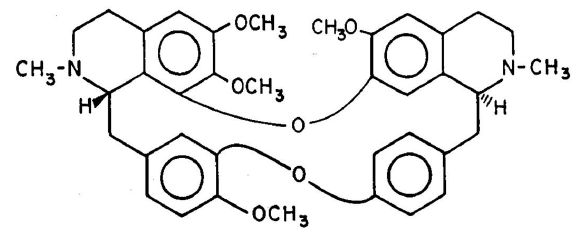
Figure 2 - Antioquine, isolated from Pseudoxandra esclerocarpa Maas.